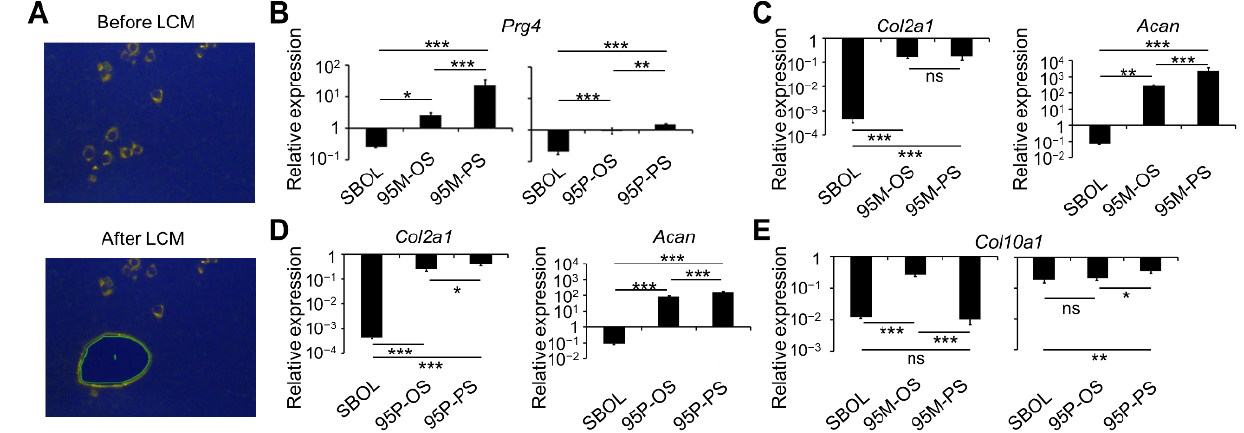
Figure 5. SBO-to-ACC differential conversion can be induced by two sets of transcription factors. SBOs were transfected with Sox9 and Sox5 together with c-Myc (95M) or Plagl1 (95P) and incubated for 14 d prior to the assessment of Col2a1 and Acan expression by RT-qPCR in laser capture microdissected (LCM) cells based on their morphology (OS or PS) and chondrogenic phenotype (positive for both COL2A1 and ACAN examined under fluorescence microscope). ( A ) Immunofluorescence stained samples (photo enhanced) before ( upper ) and after ( lower ) LCM. Magnification: 100×. ( B ) Expression of the superficial zone (SZ)-specific gene Prg4 in OS and PS cells treated with 95M and 95P. ( C , D ) Expression of Col2a1 and Acan in OS and PS cells treated with 95M ( C ) or 95P ( D ). ( E ) Assessment of the hypertrophic chondrocyte-specific marker gene Col10a1 . Data shown in the bar graph represent mean ± SD ( n = 3). Individual RNA expression levels were normalized to respective Actb expression levels and relative to natural ACCs. SBOLs served as negative control. *p < 0.05, **p < 0.01, ***p < 0.001.